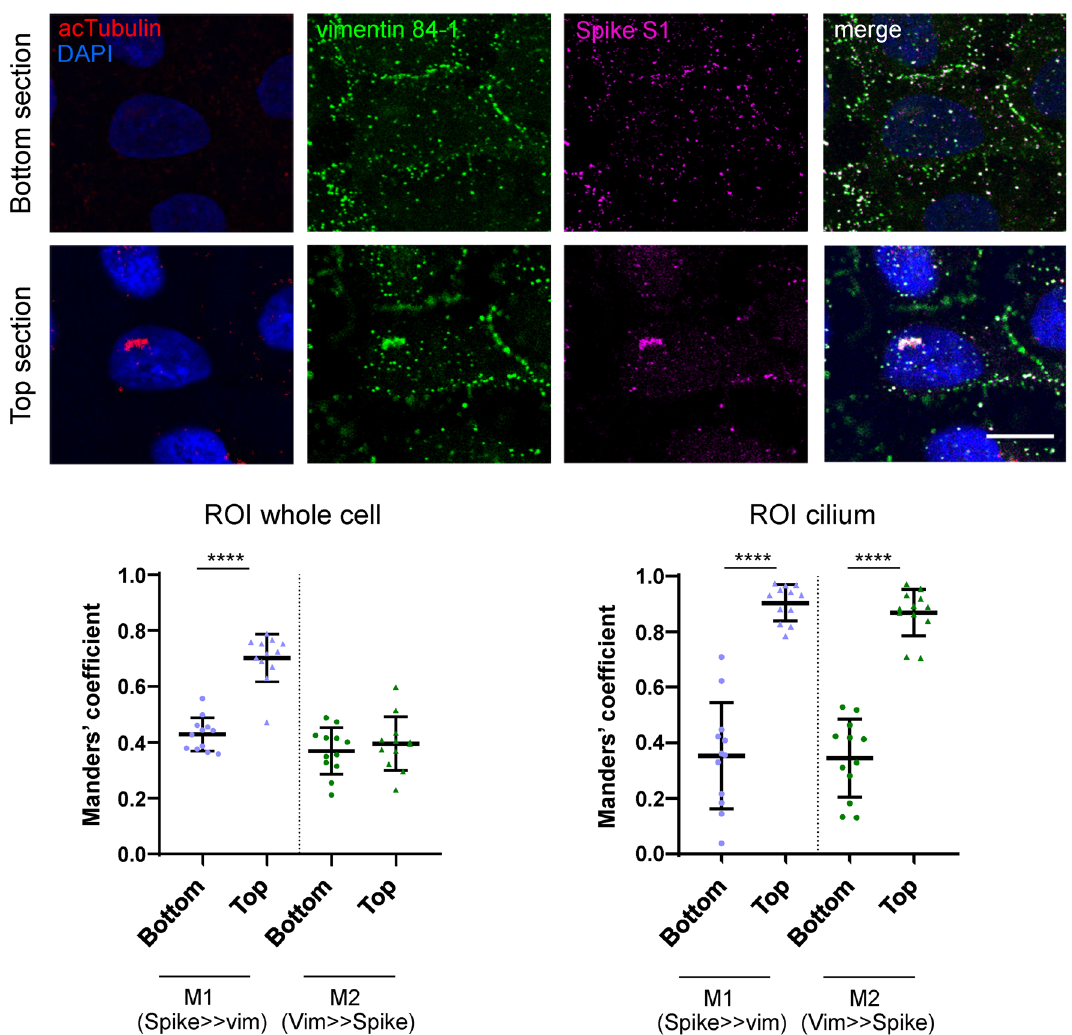
Figure 9. Selective Spike/vimentin colocalization in primary cilia. A549 were incubated with Spike S1-Fc, immunostained as in Fig. 8, and monitored by confocal microscopy. Images shown are single sections taken from the lower (bottom section, absence of cilium) or the upper third (top section, presence of cilium) of the cells, as indicated. Graphs show the Manders’ coefficients for Spike overlapping vimentin (Spike >> vim, M1) and vimentin overlapping Spike (Vim >> Spike, M2) at the basal (circles) and top (triangles) cell sections, obtained considering an individual cell (left graph) or the cilium region (right graph), as ROI. Results are average values ± SEM of 12 determinations from three different experiments. ****, p ≤ 0.0001 by unpaired Student’s t -test. Bars, 20